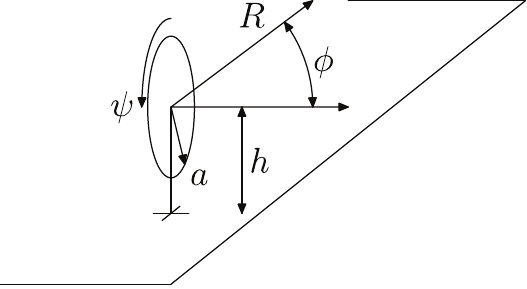
Figure 3. Coordinate system for evaluation of acoustic fi eld of ring